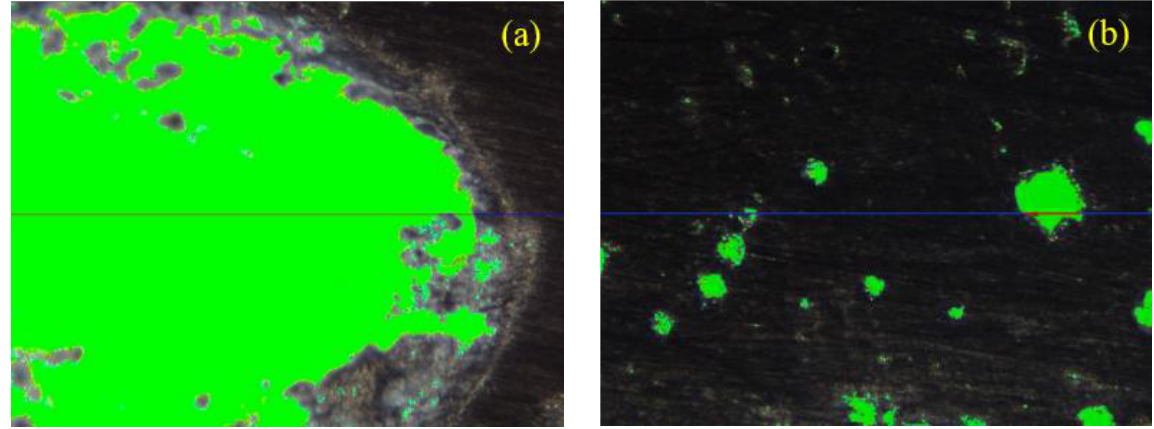
Figure 4. Principle of stomatal parameter test ( a ) the length of the line segment intercepted by the stomata; ( b ) the full length of the line in the sample.